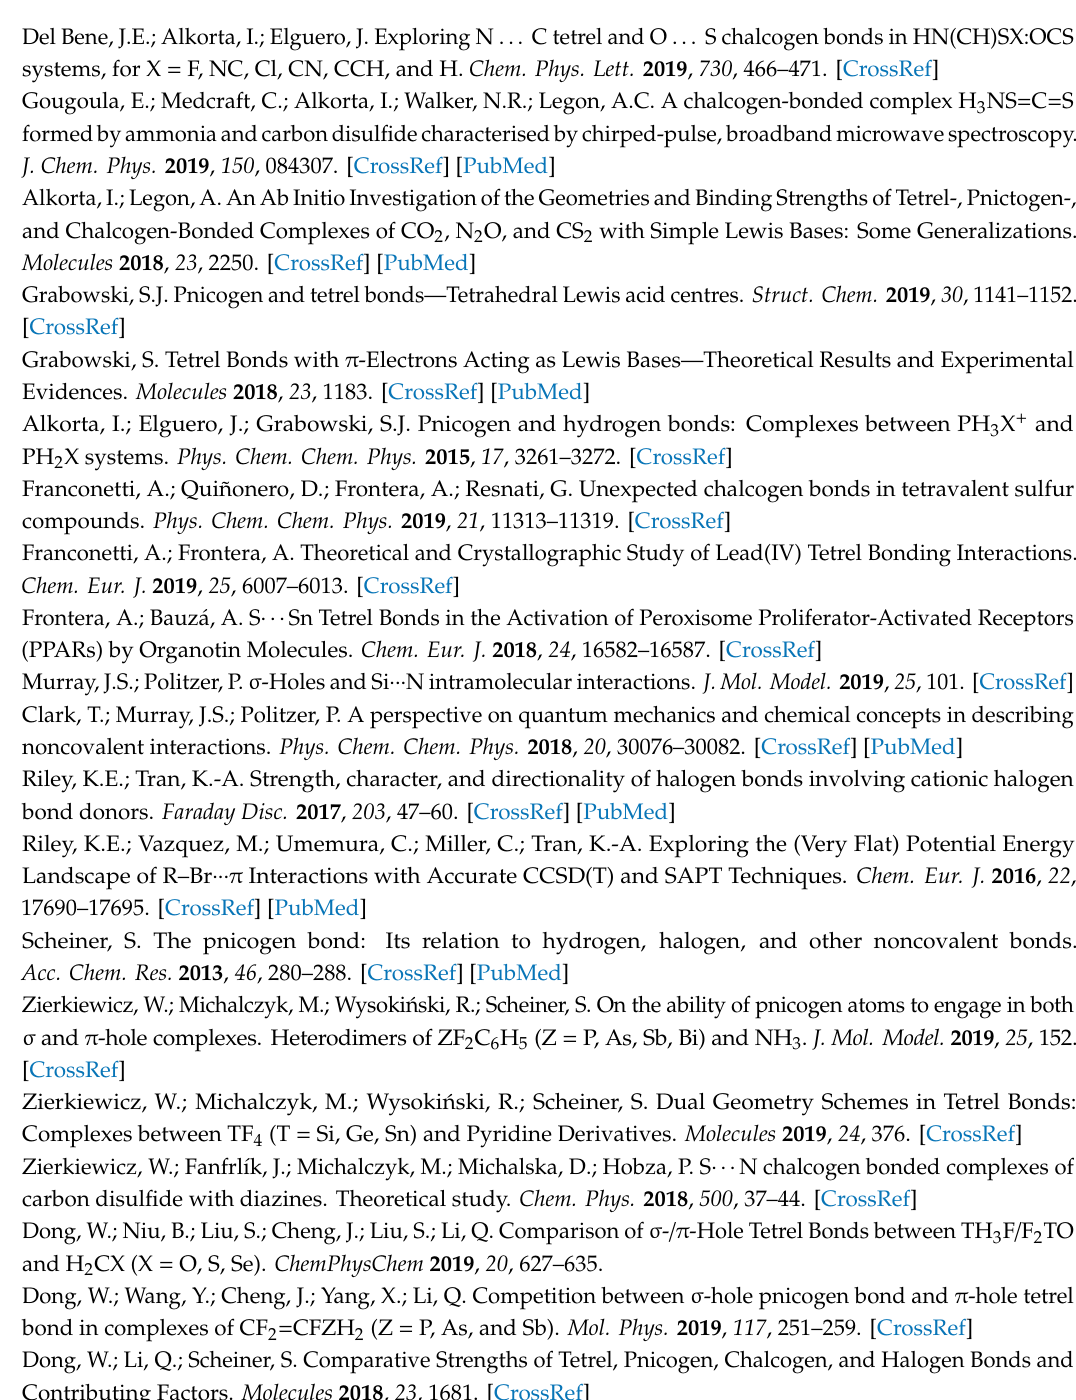
Figure S1: Optimized geometry of complexes with NH 3 ; Figure S2: Electron density shifts caused by complexation between Lewis acid and NH 3